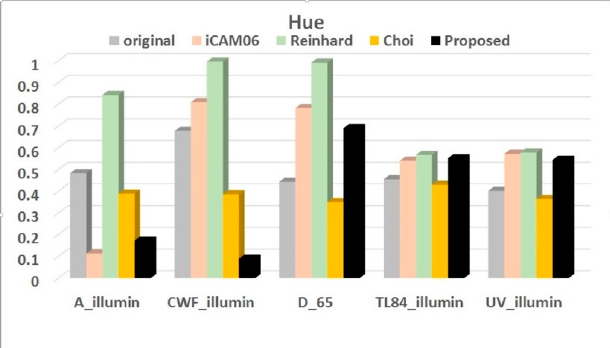
Figure 13. CIEL*a*b*-based hue comparison between the conventional and proposed tone mapping methods with the captured images under five different standard illuminations.